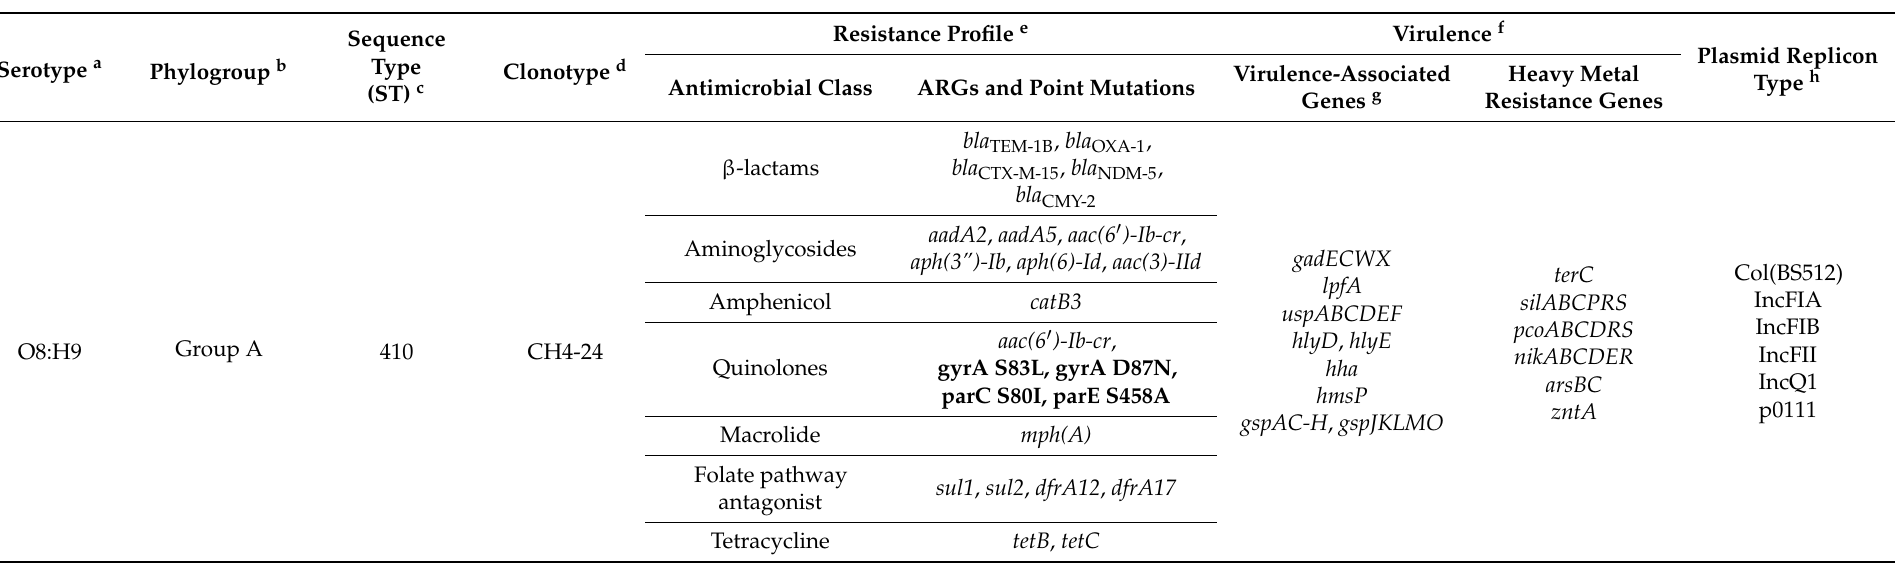
Table 2. Features, molecular typing, resistance profile, virulence-associated factors, and plasmid replicon types carried in E. coli isolate EC13655 from